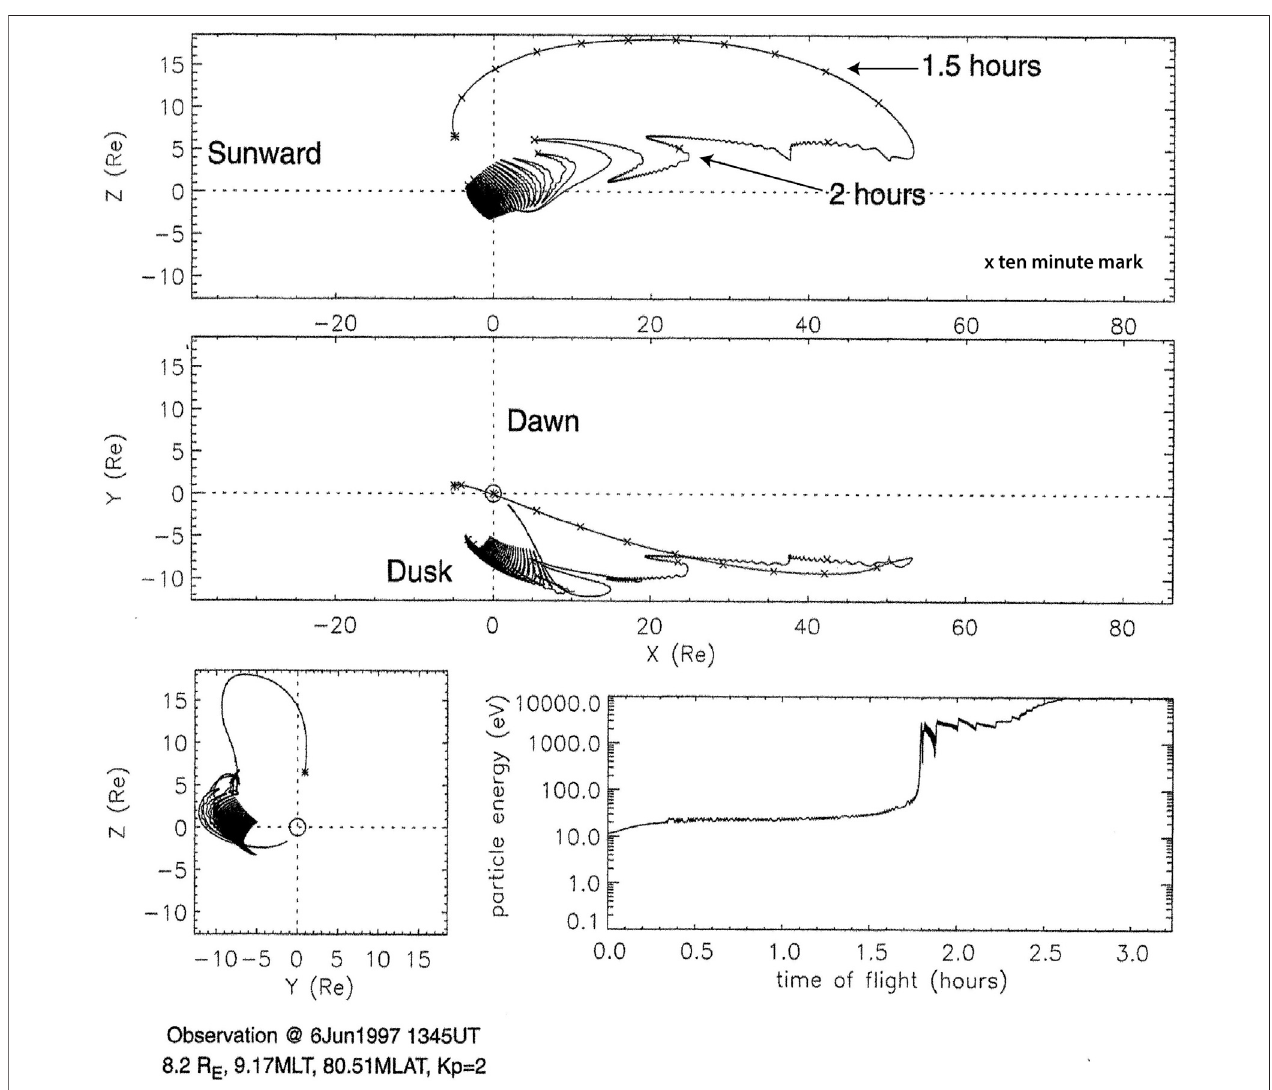
FIGURE 9 | An ion trajectory beginning above the ionosphere on the dayside and moving through the lobes and plasma sheet with its subsequent energization.